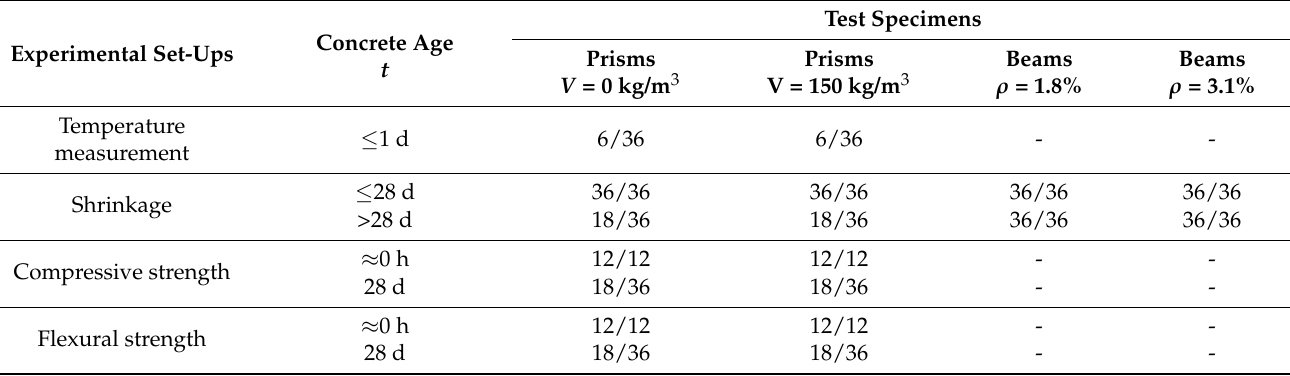
Table 2. Summary of performed tests and ratio of the tested and the total number of samples, denoted by tested/total number of prisms/beams.